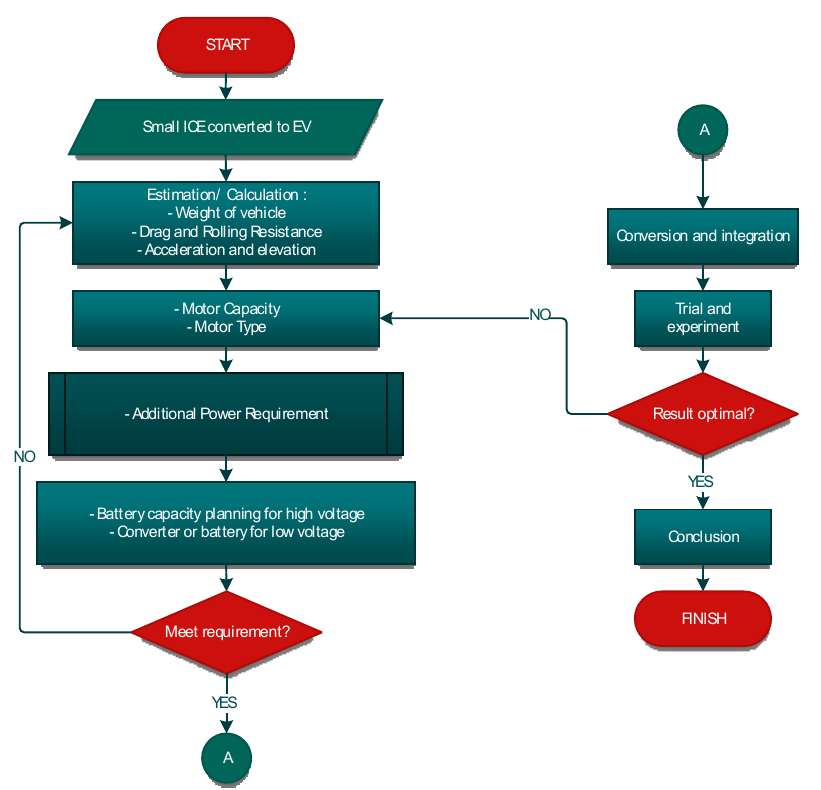
Figure 1. Power requirement planning flow chart.